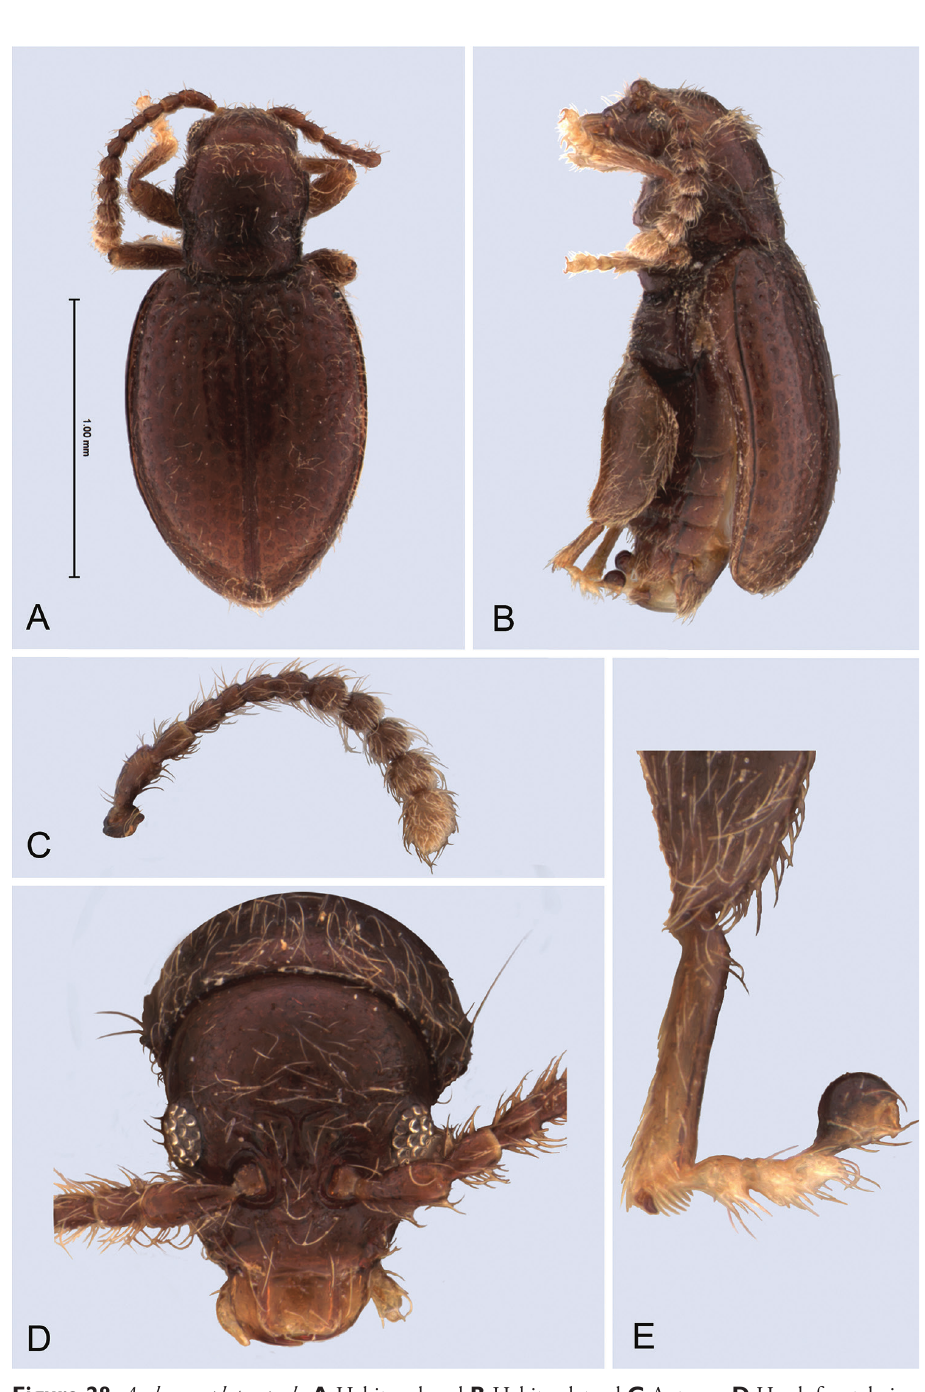
Figure 28. Andersonoplatus peck . A Habitus dorsal B Habitus lateral C Antenna D Head, frontal view E Hind